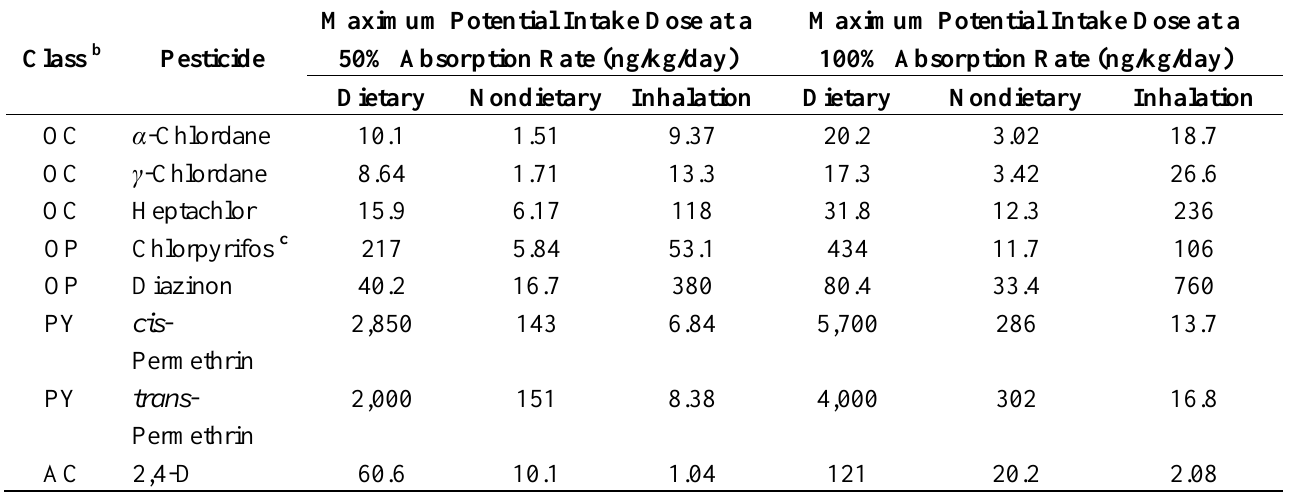
Table A1. The maximum potential intake dose of a CTEPP child for a pesticide by route when zsing either a 50% or 100% default absorption rate value a